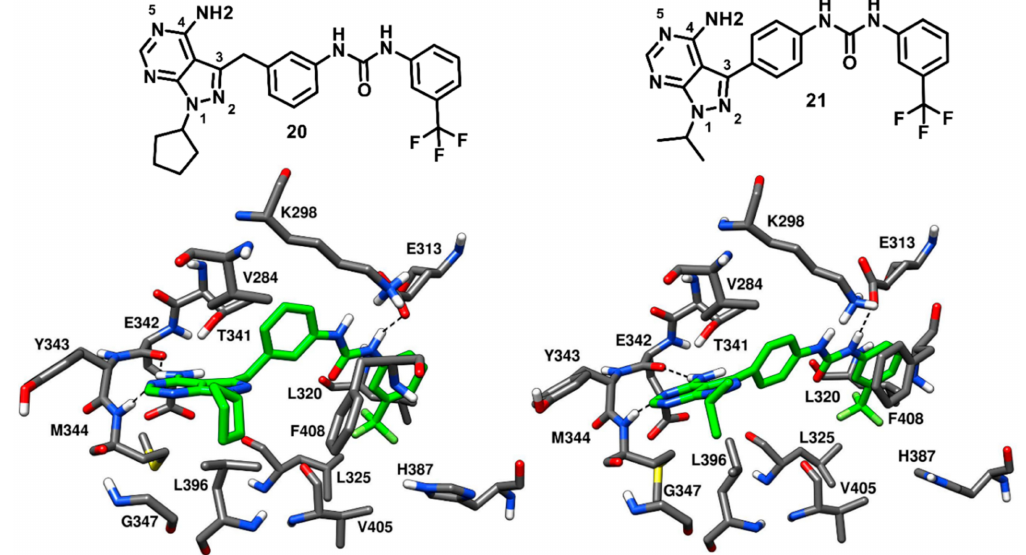
Figure 18. 2D structures of 20 and 21 . X-ray structures of c-Src kinase in complex with 20 (PDB ID: 3EL7) and 21 (PDB ID: 3EL8). Active site residues of c-Src kinase and the enzyme–inhibitor H-bond interactions are